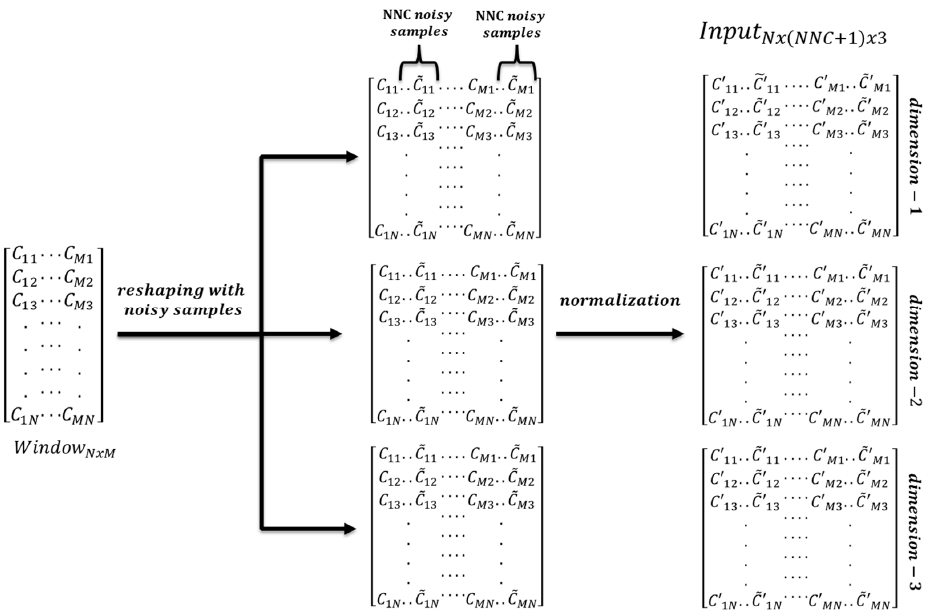
Figure 2. Windowing, Reshaping and Normalization on EEG data.